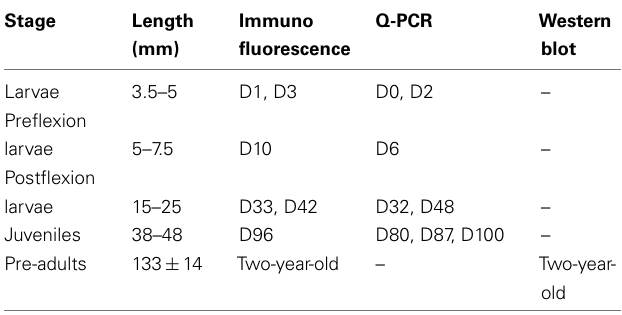
Table 1 | Dicentrarchus labrax stages used for immunofluorescence, quantitative PCR (Q-PCR) andWestern